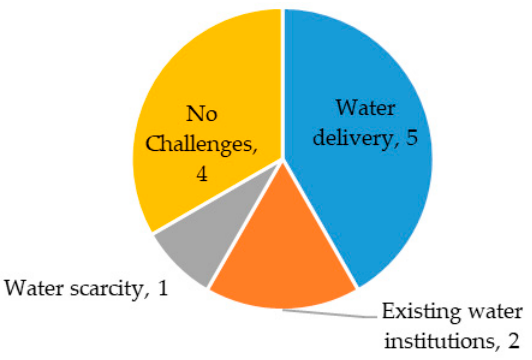
Figure 3. Baseline water supply challenges during normal water years, defined as years when snowpack is measured at 100% of normal, river flows are sustained through the summer irrigation season, or when all water rights and full allocations are met.